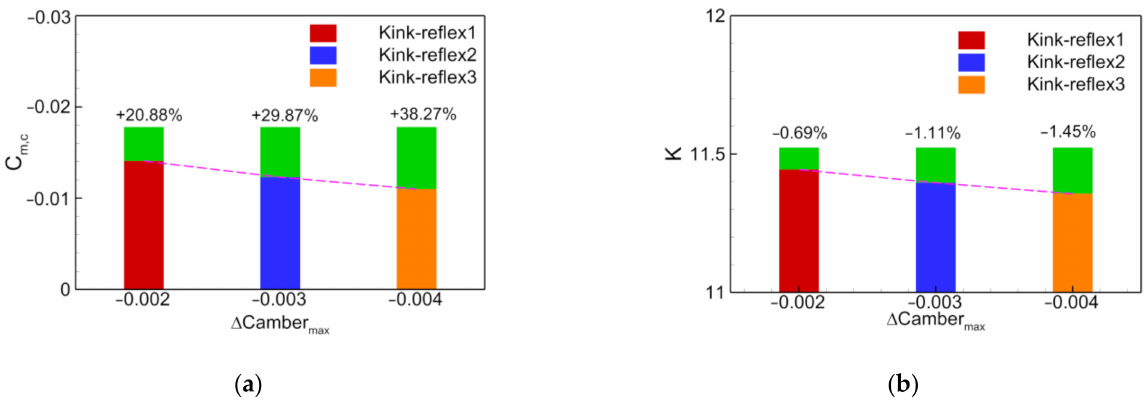
Figure 22. The increments of C m,c and K obtained by aft-reflexing the kink airfoil at cruise state. ( a ) Pitching moment coefficient; ( b ) Lift-to-drag ratio.